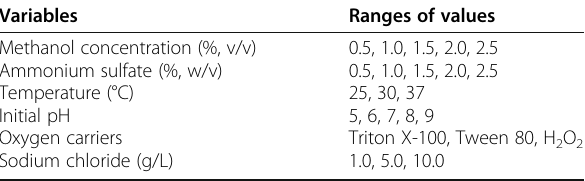
Table 2 Ranges of the culture condition variables Variables Ranges of